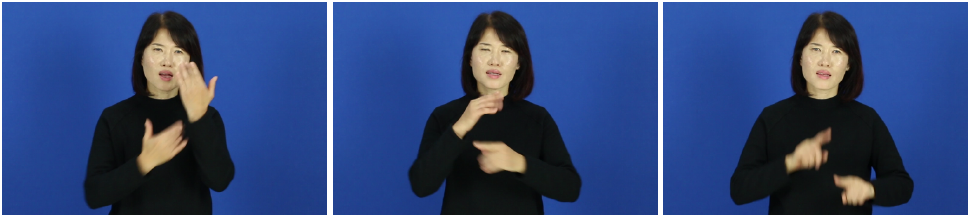
Figure 1. Example frames from our sign language dataset. The frames are extracted in a temporal order from the video for the sentence “I am burned”.